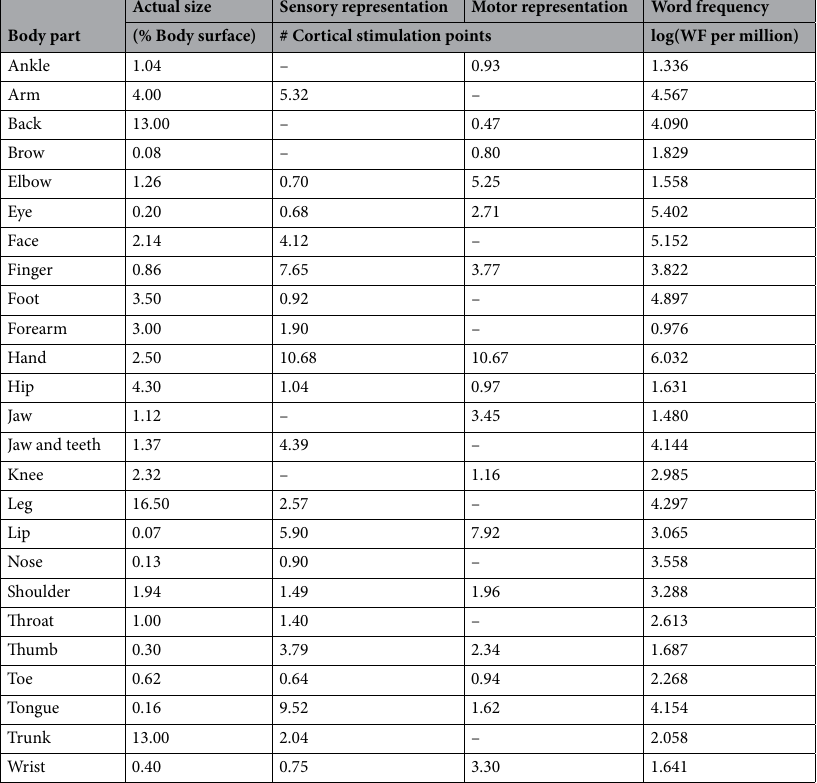
Table 2. The actual physical size, sensory and motor representational sizes, and average logarithmic word frequencies per million across all 30 languages for the 25 body parts investigated in this study (for detailed descriptions, see the Methods sections for Study 2 and